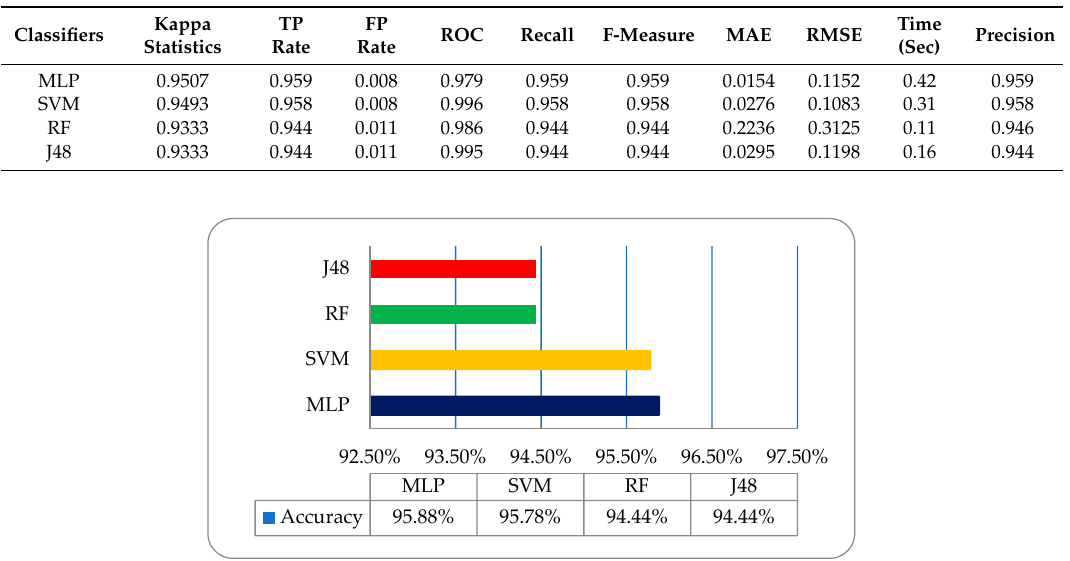
Table 3. The overall classification accuracy table of employed machine-learning (ML) classifiers on the liver cancer magnetic resonance imaging (MRI) dataset.